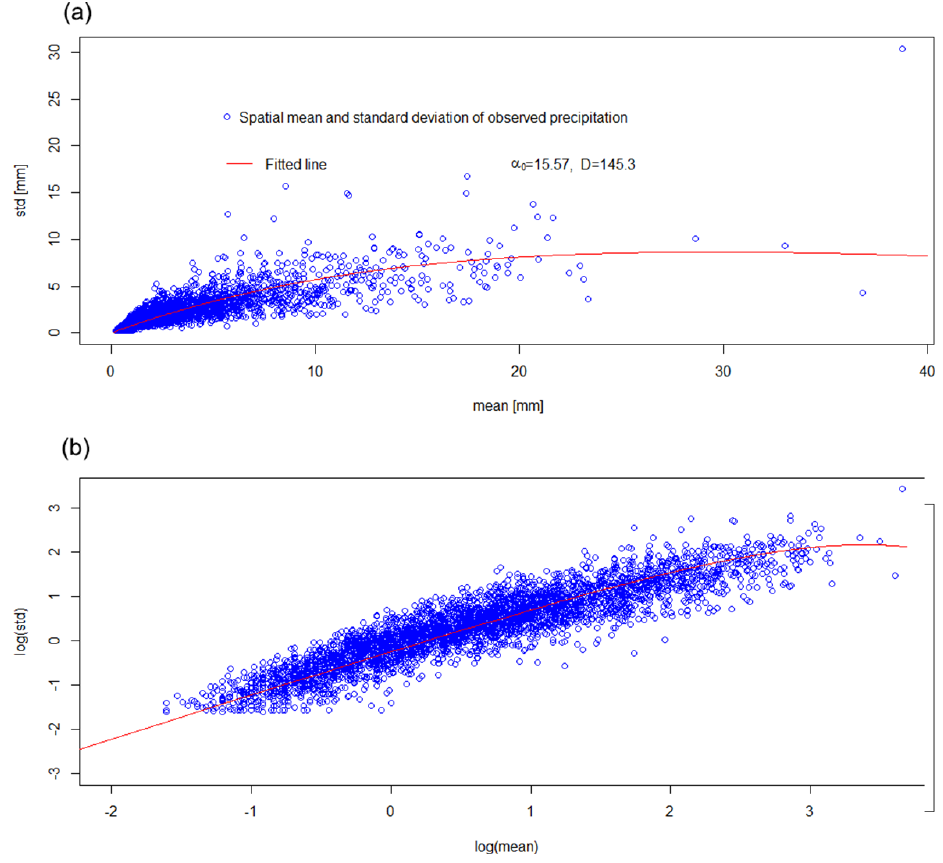
Figure 1. Scatter plot of the spatial mean and spatial standard deviation of observed precipitation over a catchment. Equation (6) is fitted to the data by nonlinear regression (red line). Bottom panel shows the scatter plot in